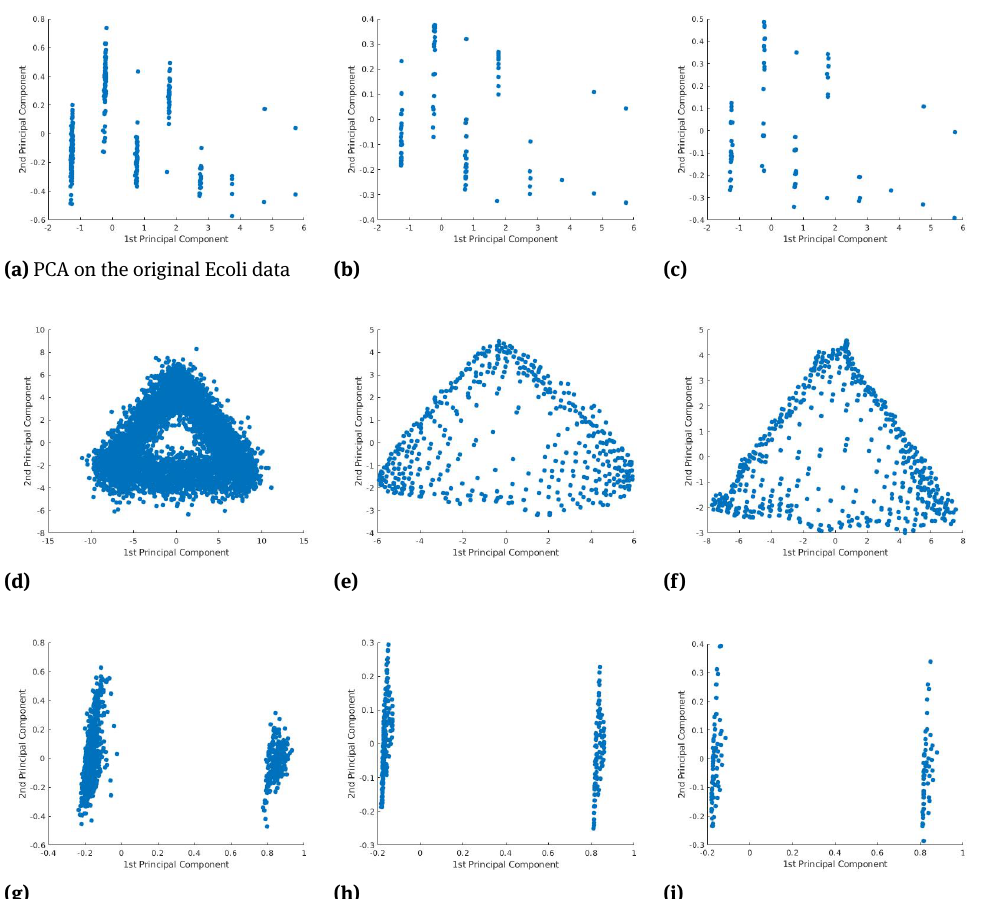
Figure 2: PCA on the anonymized datasets compared to the original